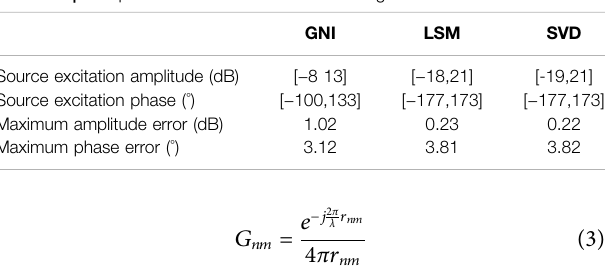
TABLE 1 | Comparison of simulation of different algorithms in 1.7 GHz.